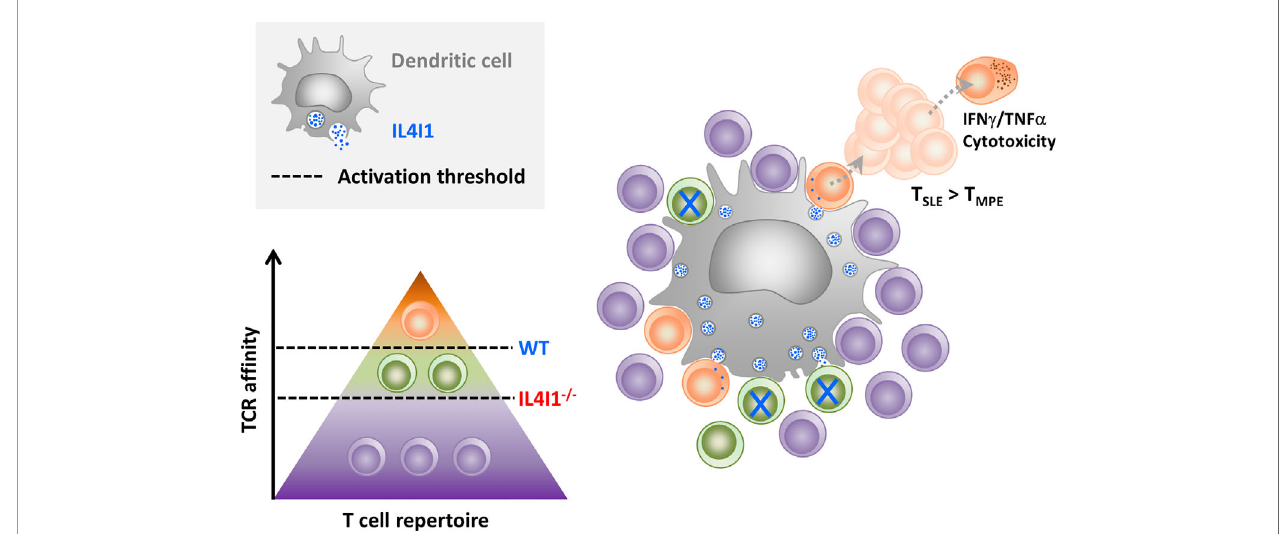
FIGURE 8 | Hypothesis for CD8-T cell priming in the presence of inhibitory IL4I1. When secreted by DCs, the IL4I1 enzyme limits stable synapse formation and inhibits the activation of antigen-speci fi c T cells. This enhances the activation threshold (dotted black line) of the polyclonal T cell population (symbolized by a pyramid), which mostly contains cells with poor or no af fi nity for the antigen (purple). In the context of a CD8 + T cell response to LCMV, this may favor the initial activation of high-af fi nity T cells (orange) at the expense of T cells with TCRs of lower af fi nity (green), as observed in WT mice. High-af fi nity clones proliferate rapidly and preferentially give rise to terminally-differentiated effector T cells. In contrast, low-af fi nity clones, which are higher in IL4I1 -/- mice, are more prone to acquire a T MPE